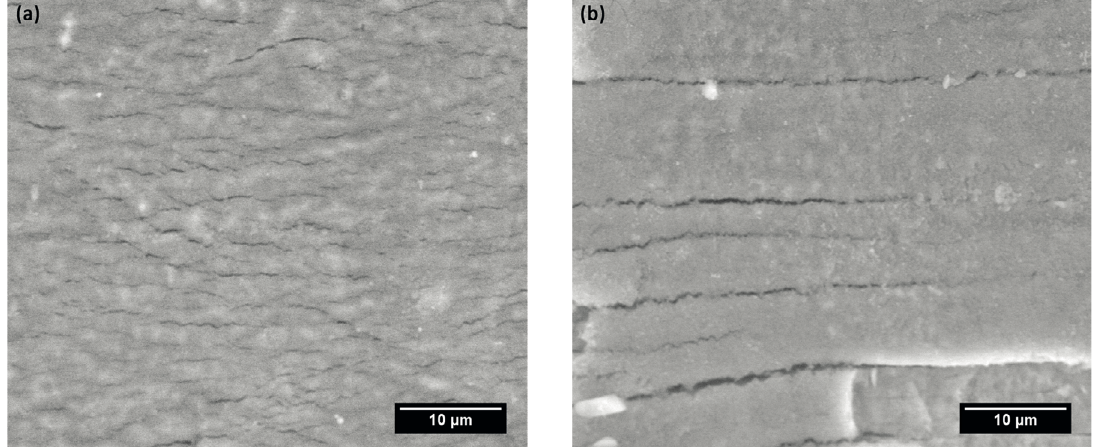
Figure 6. SEM micrographs of the nanotubes layer after the fatigue tests: (a) annealed at 450°C (anatase structure) and (b) annealed at 650°C (rutile structure).